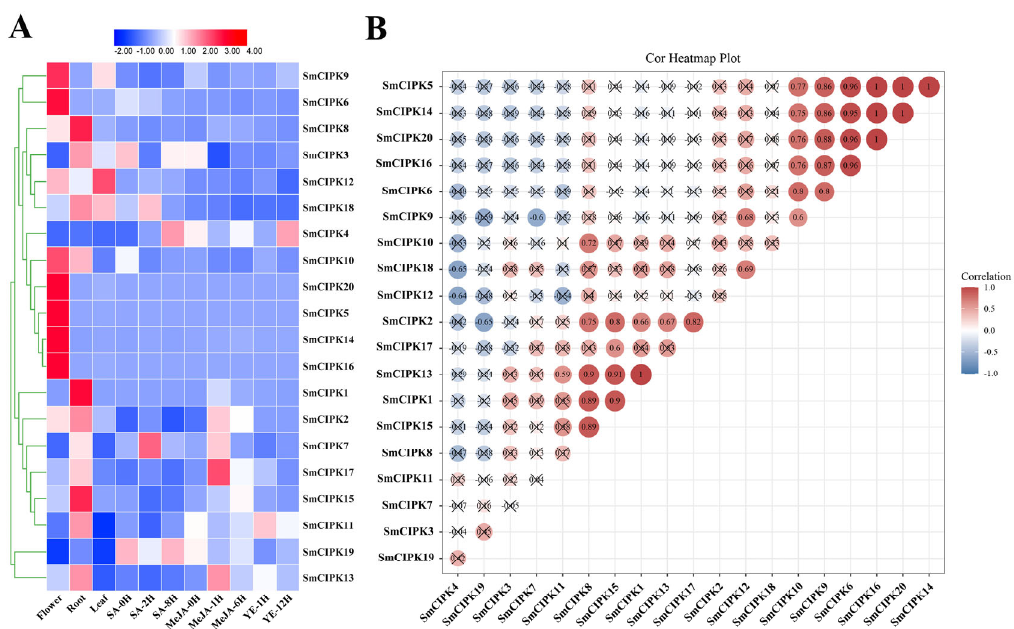
Figure 4. Expression pattern analysis of SmCIPKs . ( A ). Heat map of SmCIPKs expression in different tissues under different treatments. ( B ). Correlation analysis of the expression patterns between different SmCIPKs . Red color indicates positive correlation between two genes, blue color indicates negative correlation between two genes, and the number in each cell indicates the correlation coefficient. (Correlations > 0.5 were considered significant).